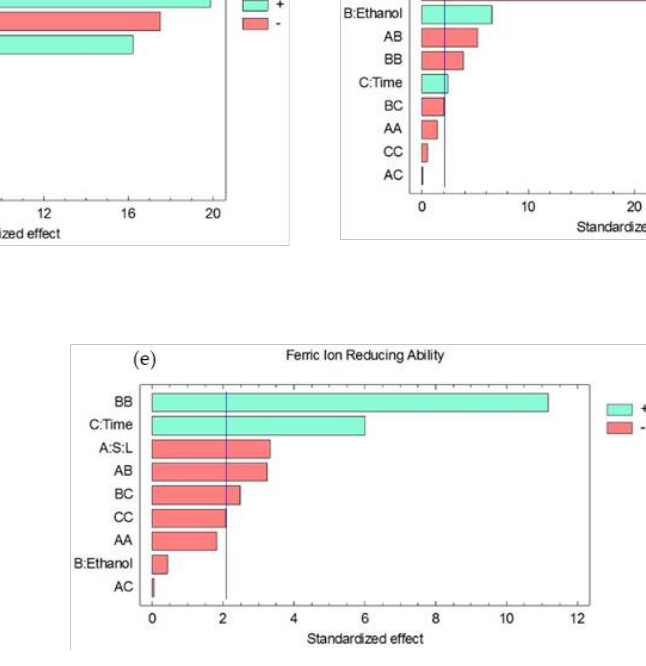
Figure 1. Standardized effects of the experimental factors on ( a ) sulforaphane, ( b ) glucoraphanin, ( c ) total polyphenols content, ( d ) free radical scavenging ability, and ( e ) ferric-ion-reducing ability. S:L means solid-to-liquid ratio. In the statistical analysis, the factor “ A ” refers to solid-to-liquid ratio, “ B ” refers to ethanol concentration in the extracting solution, and “ C ” refers to extraction time.